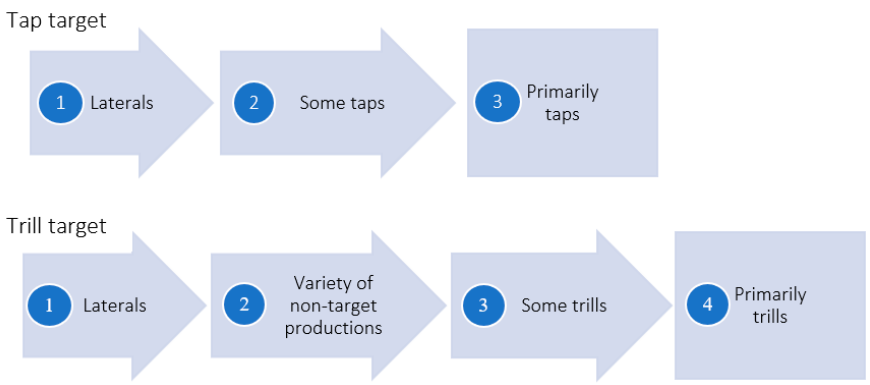
Figure 5. Developmental patterns of acquisition of the Spanish rhotics by L1 Mandarin–L2 English–L3 Spanish speakers.